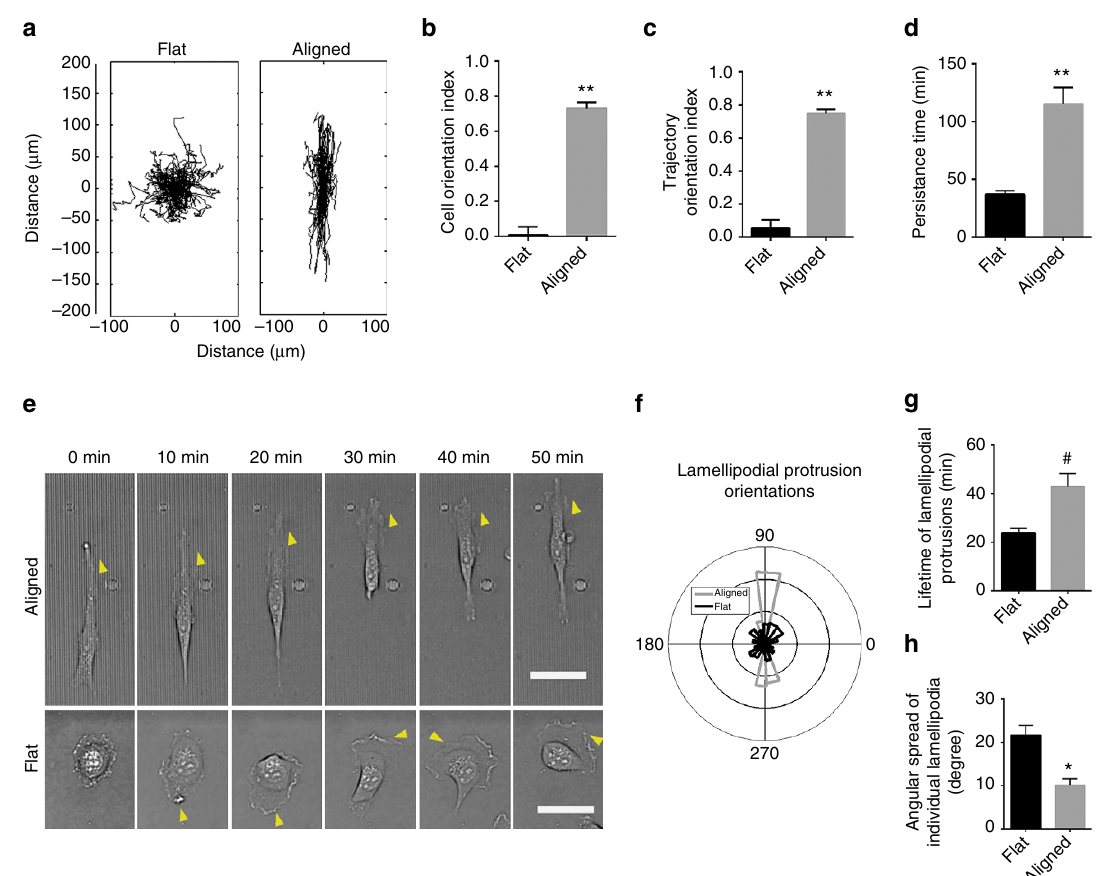
Figure 2 | Stable membrane protrusions highly constrained to the direction of ECM alignment are associated with contact guidance-directed migration. ( a ) Migration trajectory map of MDA-MB-231 cells on flat and topographically aligned substrates. ( b , c ) Cell orientation ( b ) and Trajectory orientation ( c ) indices for MDA-MB-231 cells on flat versus nanopatterned substrates showing significantly greater directed migration due to contact guidance ( n 4 75 cells per group). ( d ) Persistence time of MDA-MB-231 cells on flat and aligned substrates ( n 4 85 cell per group). ( e ) Timelapse montage of lamellipodia dynamics over time for MDA-MB-231 cells on flat versus aligned substrates. Arrowheads highlight protrusion stability on aligned ECM or frequent change in direction for cells on flat substrates. Scale bar, 50 m m. ( f ) Wind-rose plot of MDA-MB-231 lamellipodia protrusion orientations showing highly directed protrusion dynamics for cells on aligned ECM ( n 4 400 lamellipodia per group). ( g , h ) Lamellipodia lifetime ( g ) and Angular spread ( h ) for MDA-MB-231 cells on flat versus aligned substrates demonstrating significantly greater protrusion stability and directionality for cells on aligned ECM ( g : n 4 75 per group; h : n ¼ 28 per group). Data in b – d , f – h are mean ± s.e.m. ** P o 0.0001, * P o 0.01, # P o 0.001 (unpaired t -test with